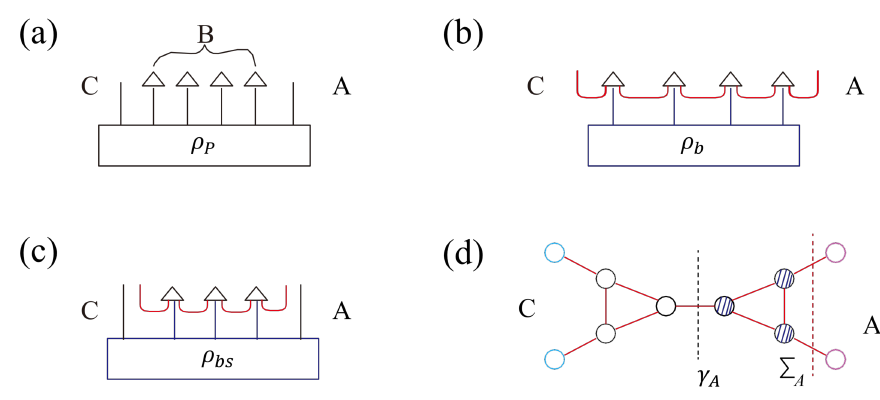
Figure 1 . (a) A general random tensor network, with each triangle representing a vertex state. ρ P is generally a mixed state. Each line here (and also in subfigures (b) and (c)) corresponds to a pair of indices, labeling a complete basis in H x ⊗ H . (b) and (c) Two examples of RTN with ρ P factorized into bulk QFT state ρ b and EPR pairs (red curves). The difference between (b) and (c) is whether the boundary is maximally entangled with its complement in ρ P . (d) A more specific example of RTN, where we have only drawn the EPR pairs. In this simple case, the entropy of boundary region A (purple circles on the right-hand side) is determined by the number of links at the minimal cut γ A (black dashed line), and the Holevo information is determined by the difference between the area of A (number of links crossing the red dashed line) and that of γ A